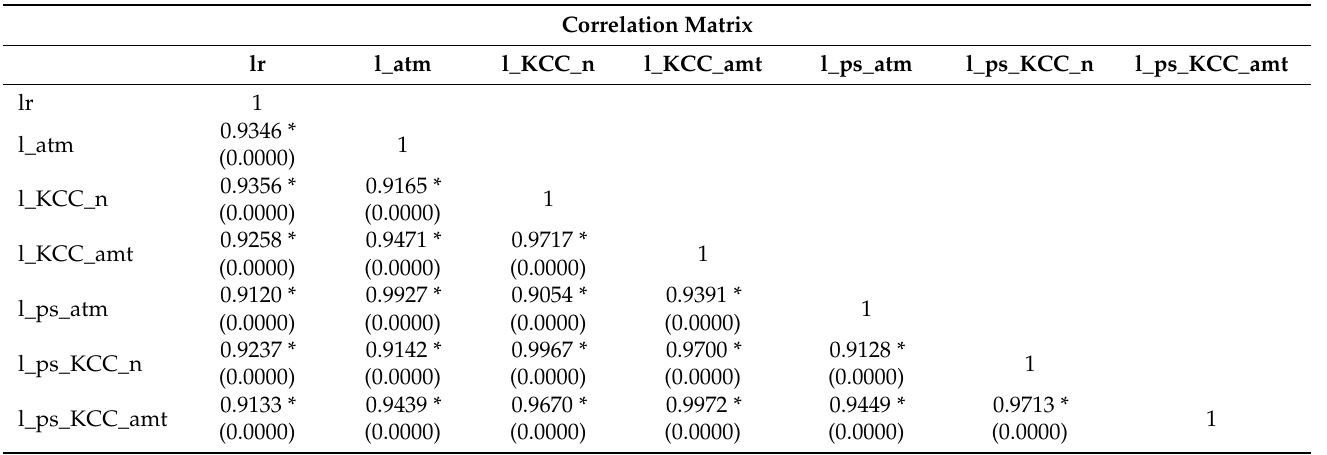
Table 3. Correlation